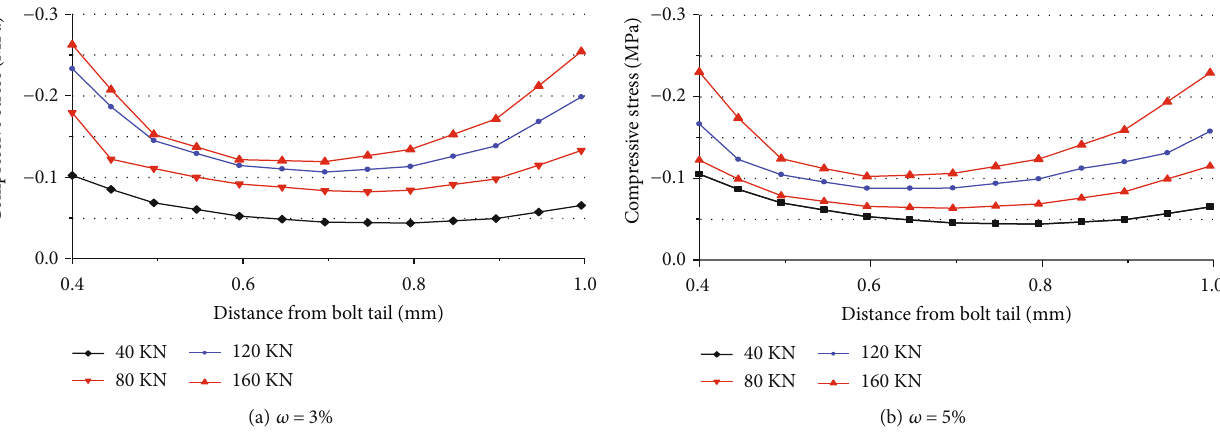
Figure 9: Distribution curve of compressive stress along the bolt axis direction.